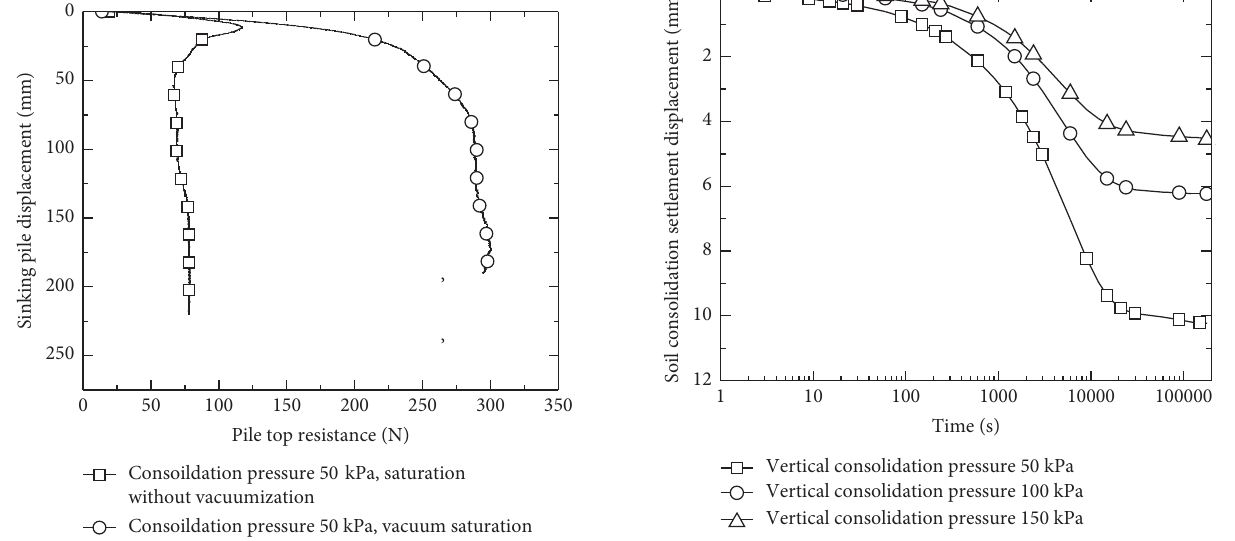
Figure 7: Relationship curve for pile tip resistance-pile sinking settlement.